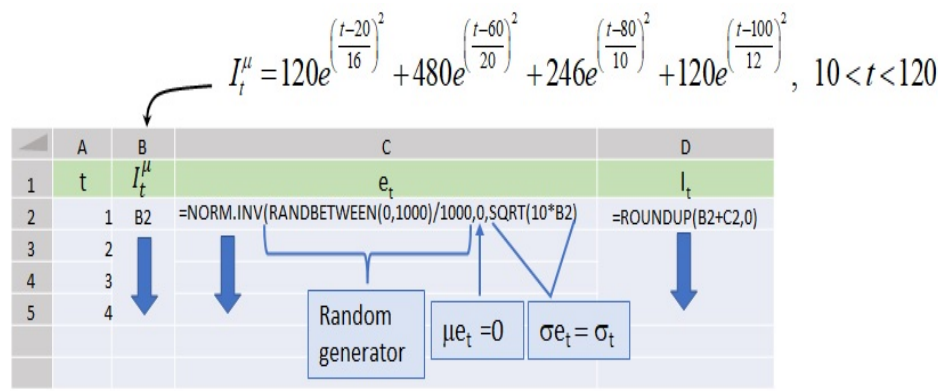
Figure 2. Generation of random incidences I t applying special functions in an MSExcel spreadsheet.